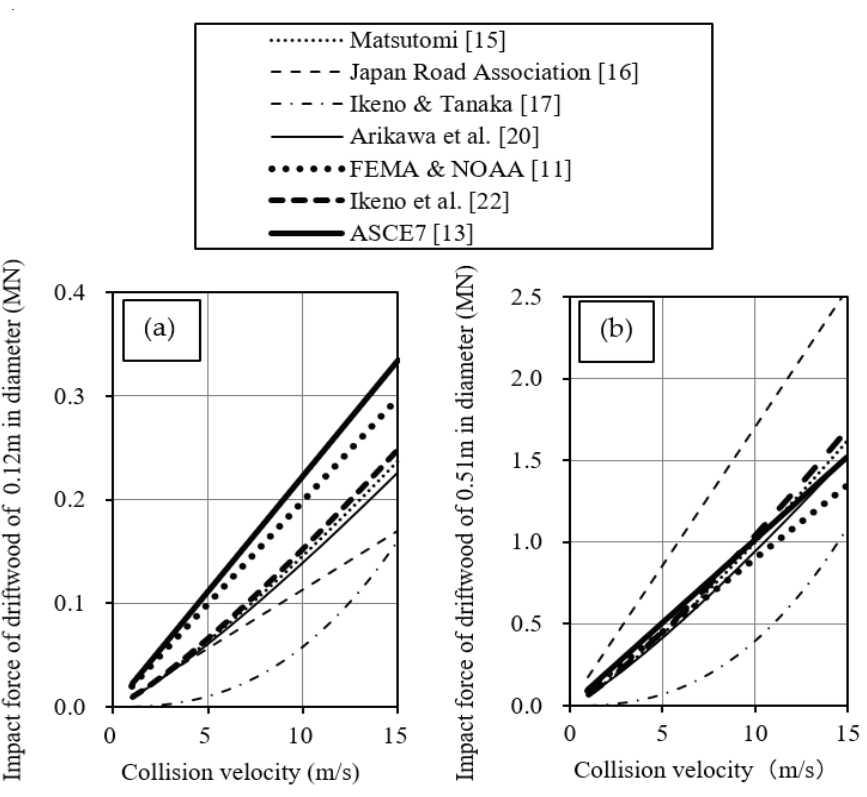
Figure 9. Impact force of driftwood: ( a ) the case of the slender wood, and ( b ) the case of the thick wood.